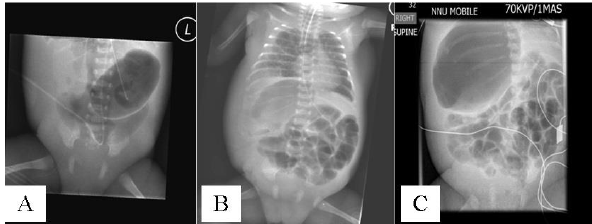
Figure 3: (A): AXR of case 3 done on day 14 of life, taken at the referring hospital showing free air in the abdomen. This finding was missed at the referring hospital; (B): AXR of case 3 done on day 24 of life, showing localized gas shadow in the right upper quadrant; (C): AXR of case 3 done on 26 of life, showing persistent localized gas shadow in the right upper